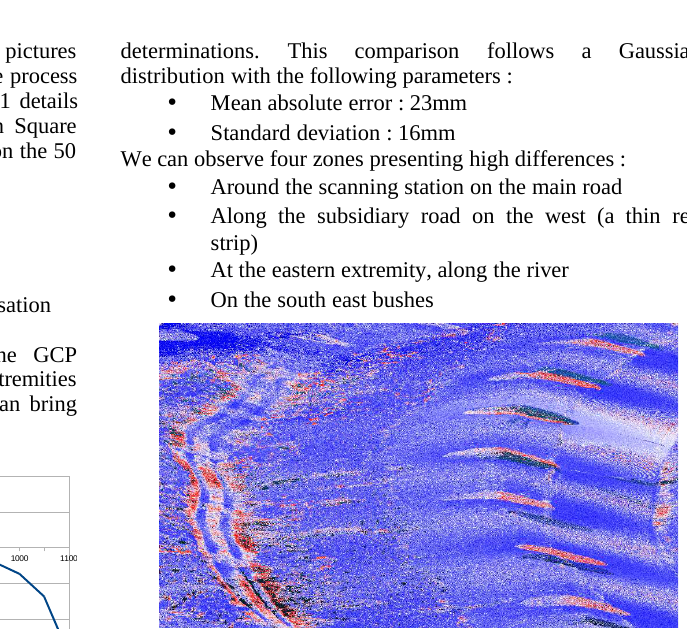
meterFigure 6: Zoom on some imprecisions between surveys